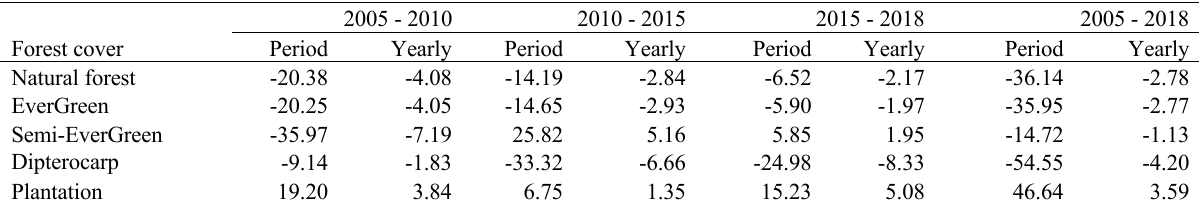
Table 4. The percentage (%) of area change of forest cover